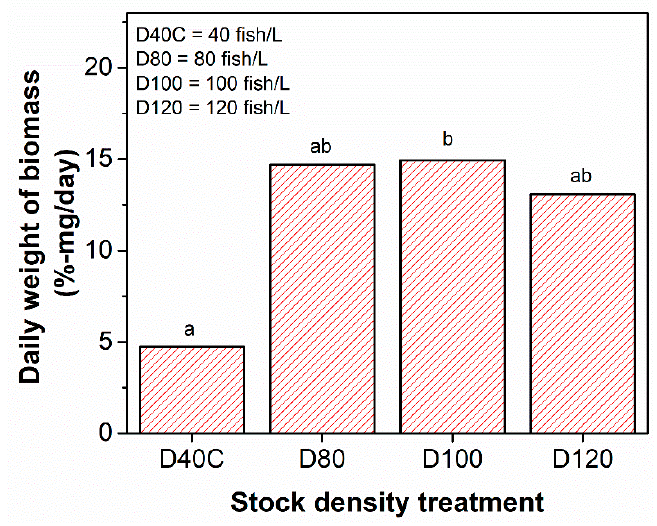
Figure 7. The specific growth rate of biomass striped catfish ( Pangasianodon hypophthalmus ) larvae at various stock density treatment levels in exogenous stage, at mean temperature of 27 °C. Vertical bars indicate standard error. Different letters denote significant differences between groups ( p < 0.05).